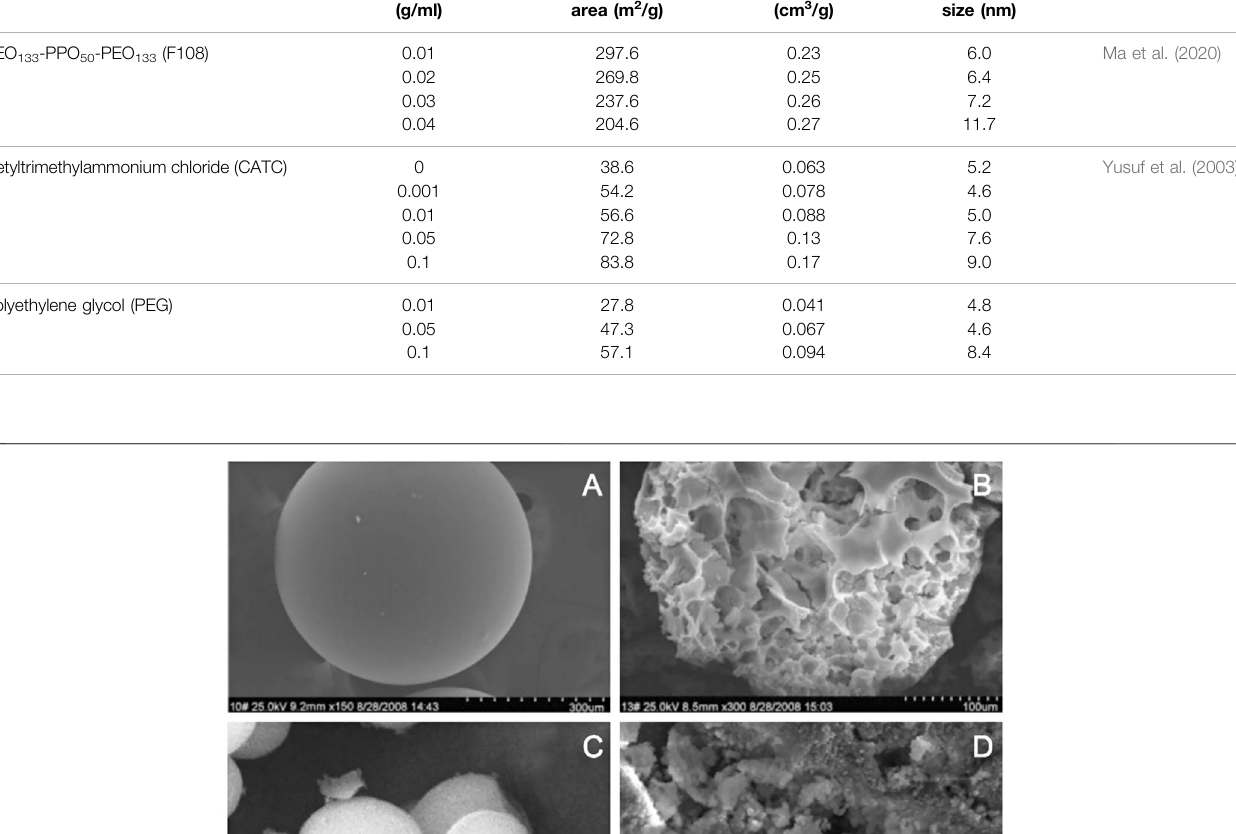
TABLE 2 | Structural parameters of the samples synthesized with different concentrations of templates. Template agent